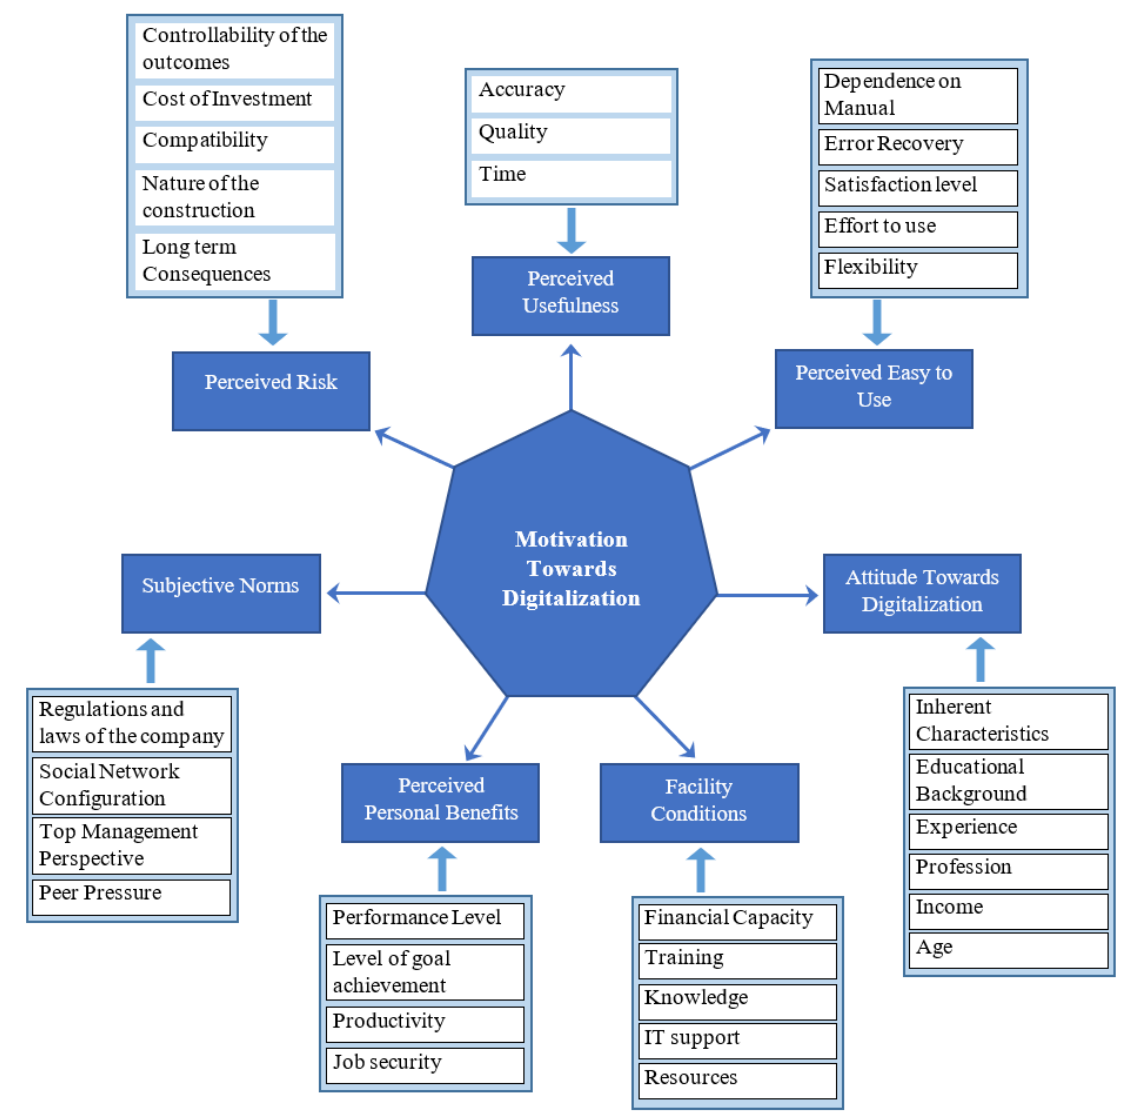
Figure 2. Factors associated with constraints.